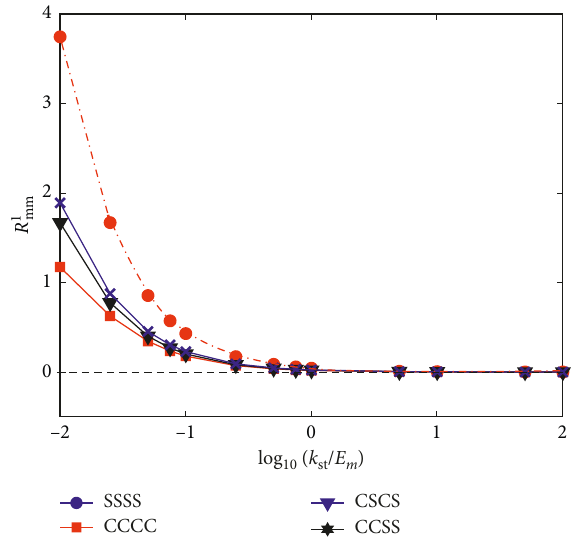
Figure 7: The effect of ratio k h h � 1. n / m